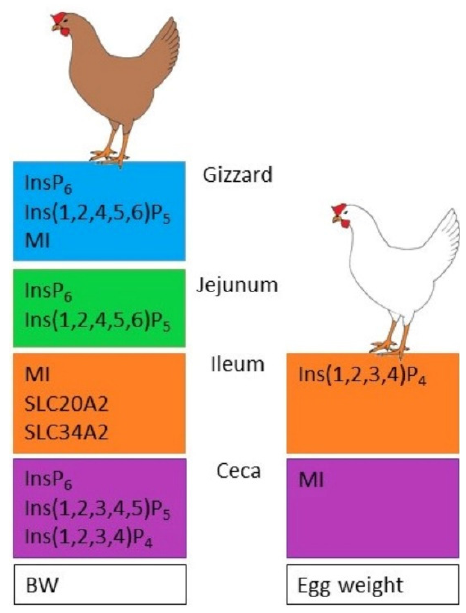
Figure 1. Summary of traits that were shown to be significantly higher in one laying hen strain than in the other.